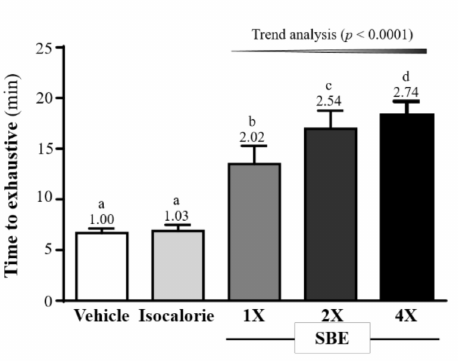
Figure 1. Effect of supplementation with SBE on exhaustive swimming time in mice. Data are expressed as mean ± SD ( n = 10 mice per group). The different superscript letters (a, b, c, d) above each bar indicate a significant difference between the groups ( p < 0.05).